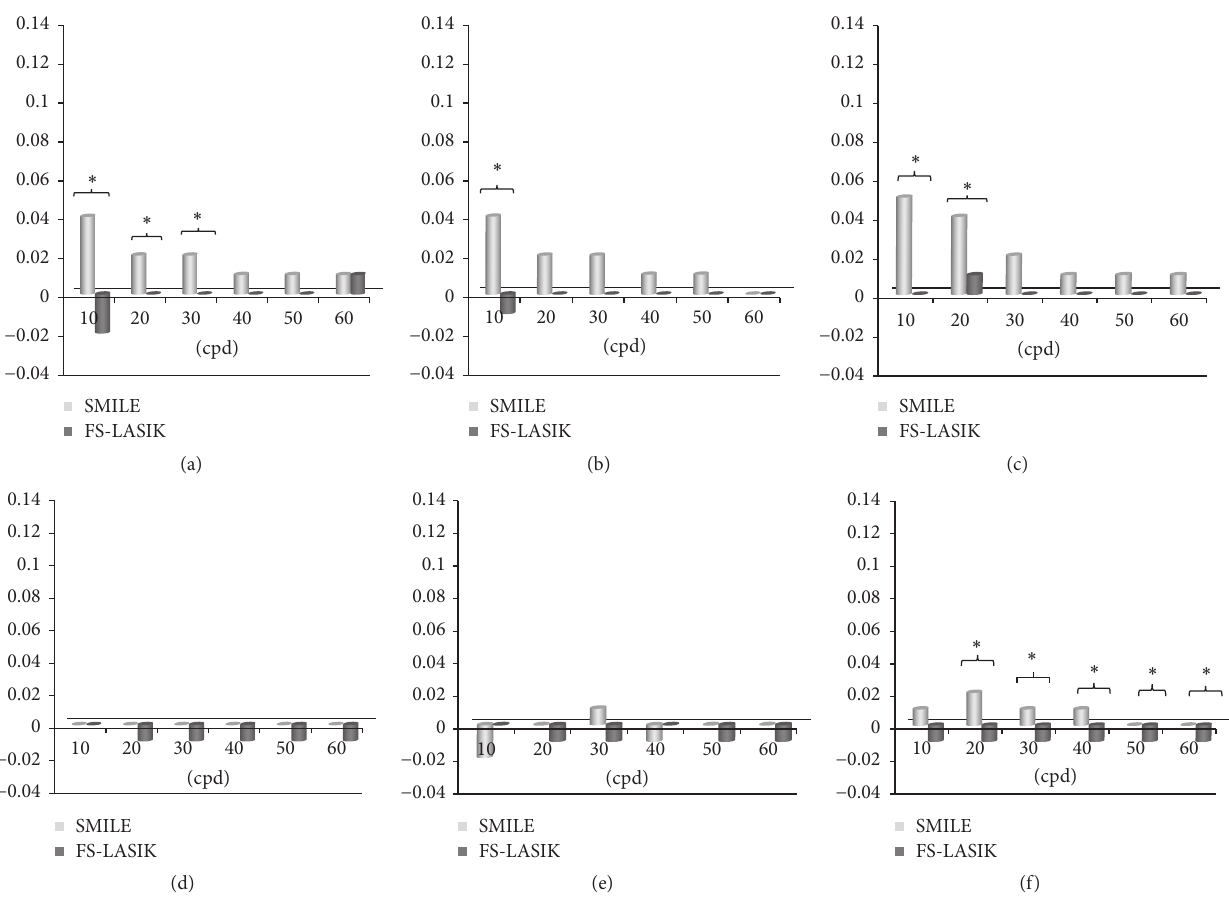
Figure 4: The changes in Δ MTF values at 6 mm pupil diameter (postoperative-preoperative MTF value) between SMILE and Femto-LASIK procedures at 1 week, 1 month, and 3 months postoperatively. (a) The change of Δ MTF at vertical meridian at 1 week postoperatively; (b) the change of Δ MTF at vertical meridian at 1 month postoperatively; (c) the change of Δ MTF at vertical meridian at 3 months postoperatively; (d) the change of Δ MTF at horizontal meridian at 1 week postoperatively; (e) the change of Δ MTF at horizontal meridian at 1 month postoperatively; (f) the change of Δ MTF at horizontal meridian at 3 months postoperatively. ∗ Significant differences ( 𝑃 < 0.05 ) in Δ MTF between SMILE and Femto-LASIK